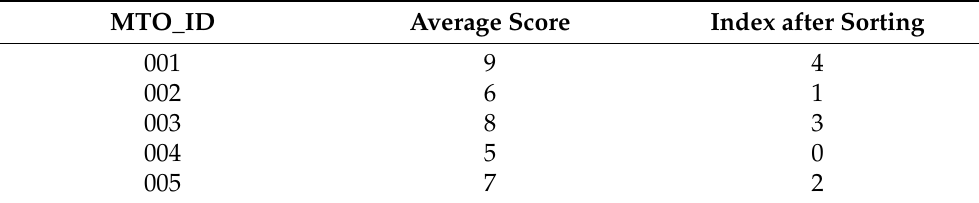
Table 2. The average score from all students for the MTO.